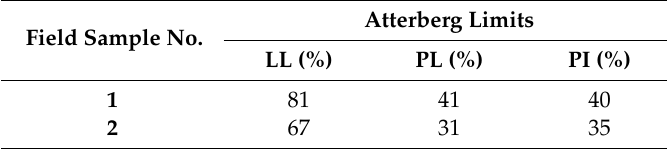
Table 5. Laboratory Atterberg limit test result of the soil samples.